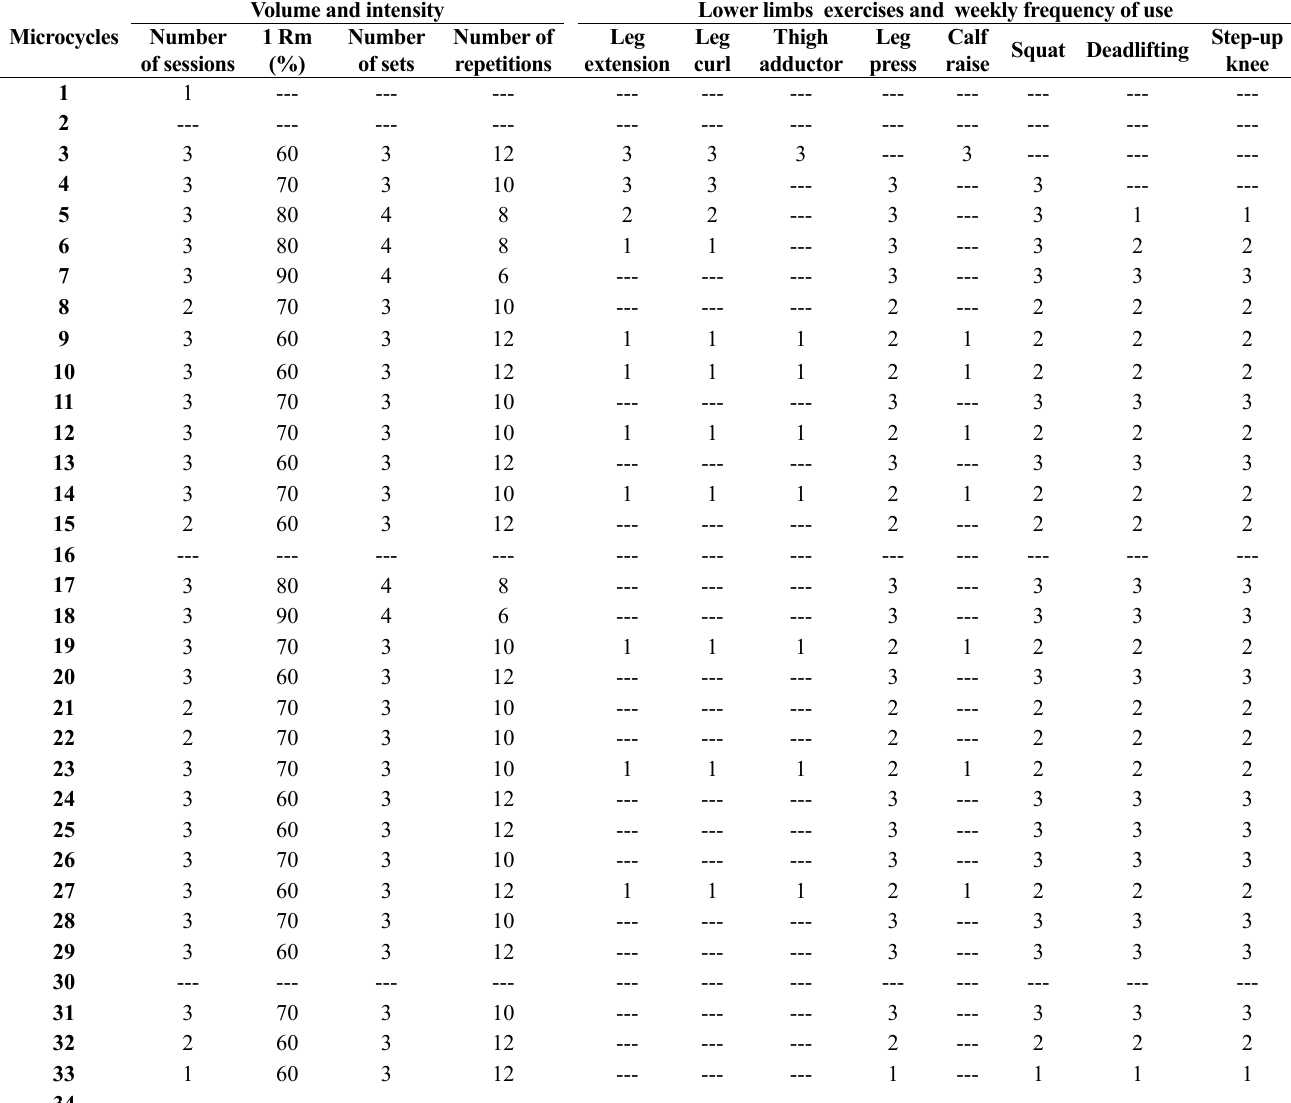
Table 2. Description of strength training